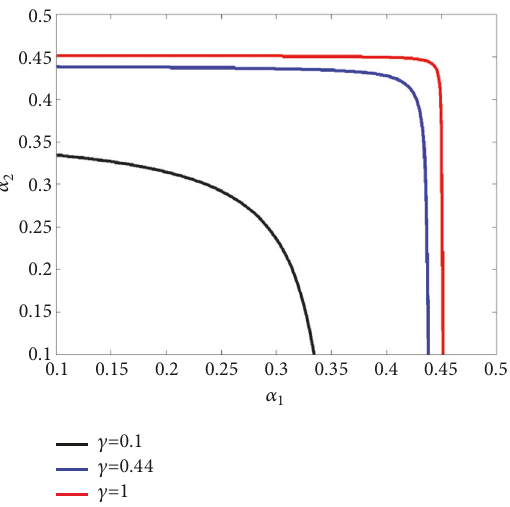
Figure 2: The stability curves of the Nash equilibrium point 𝐸 3 on the parameter plane (𝛼 1 , 𝛼 2 ) with different values of 𝛾